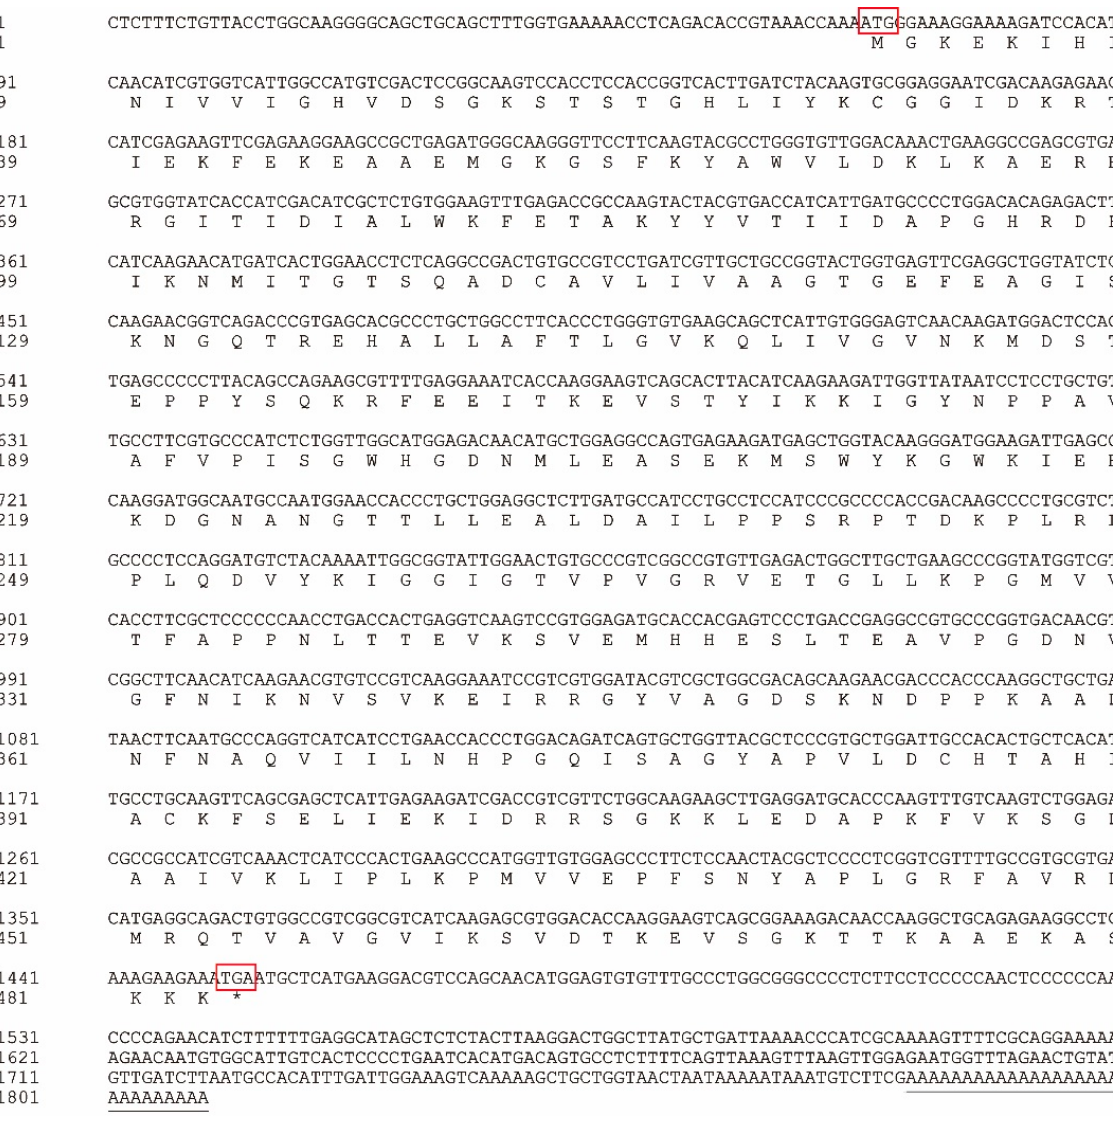
Figure 1. Analysis of nucleotide and deduced amino acid sequence of C. semilaevis eef1a1 . The initiation codon and termination codon are boxed and colored red. The stop codon is indicated as an asterisk (*). The polyadenylation signal is indicated with a single line.